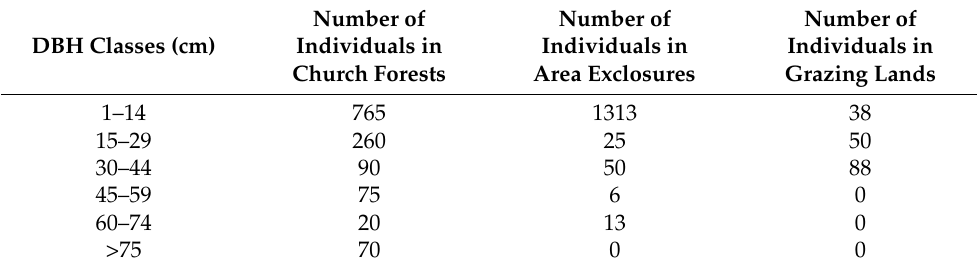
Table 3. Population status in different DBH-classes in highland study